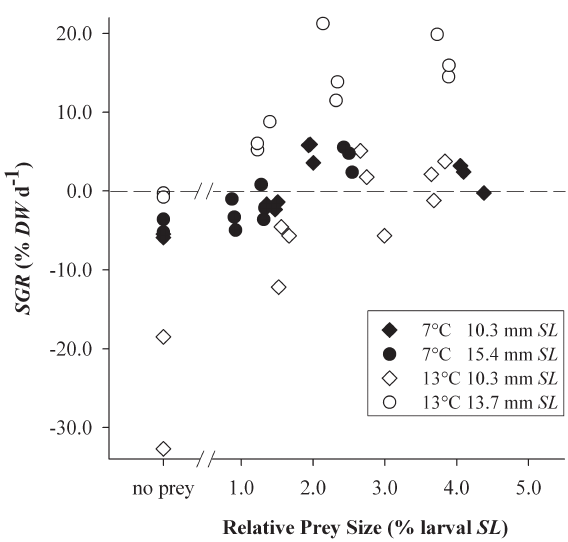
F IG . 1. – Observed specific growth rate ( SGR, % DW d -1 ) for the four growth trials (two larval ages, two temperatures) at starvation conditions and at different relative prey sizes (% larval SL ). Values are tank means. The dashed line indicates zero